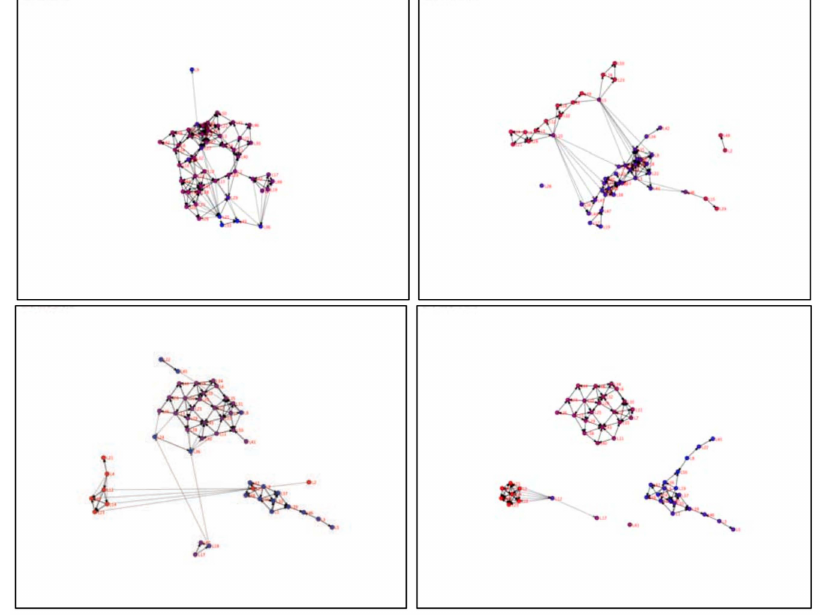
Figure 5. Snapshots from four timesteps of a dynamic network view of the “Peace”